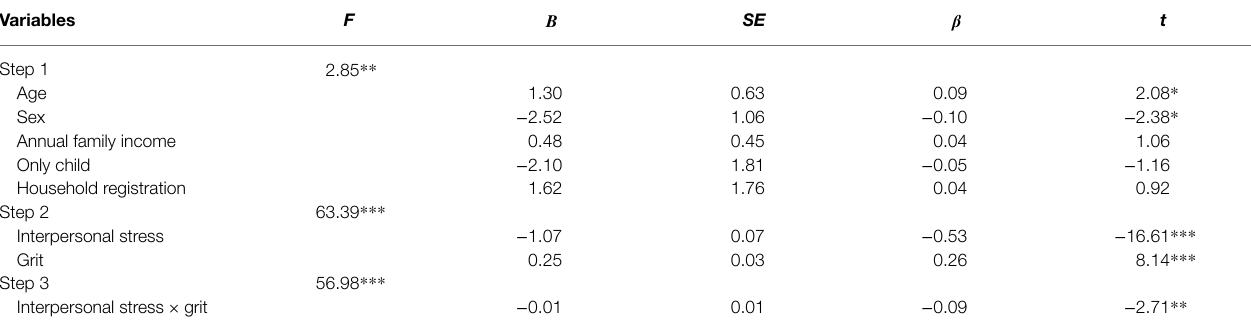
TABLE 4 | Analysis of the moderating effect of grit on interpersonal stress and psychological security in Study 2. Variables